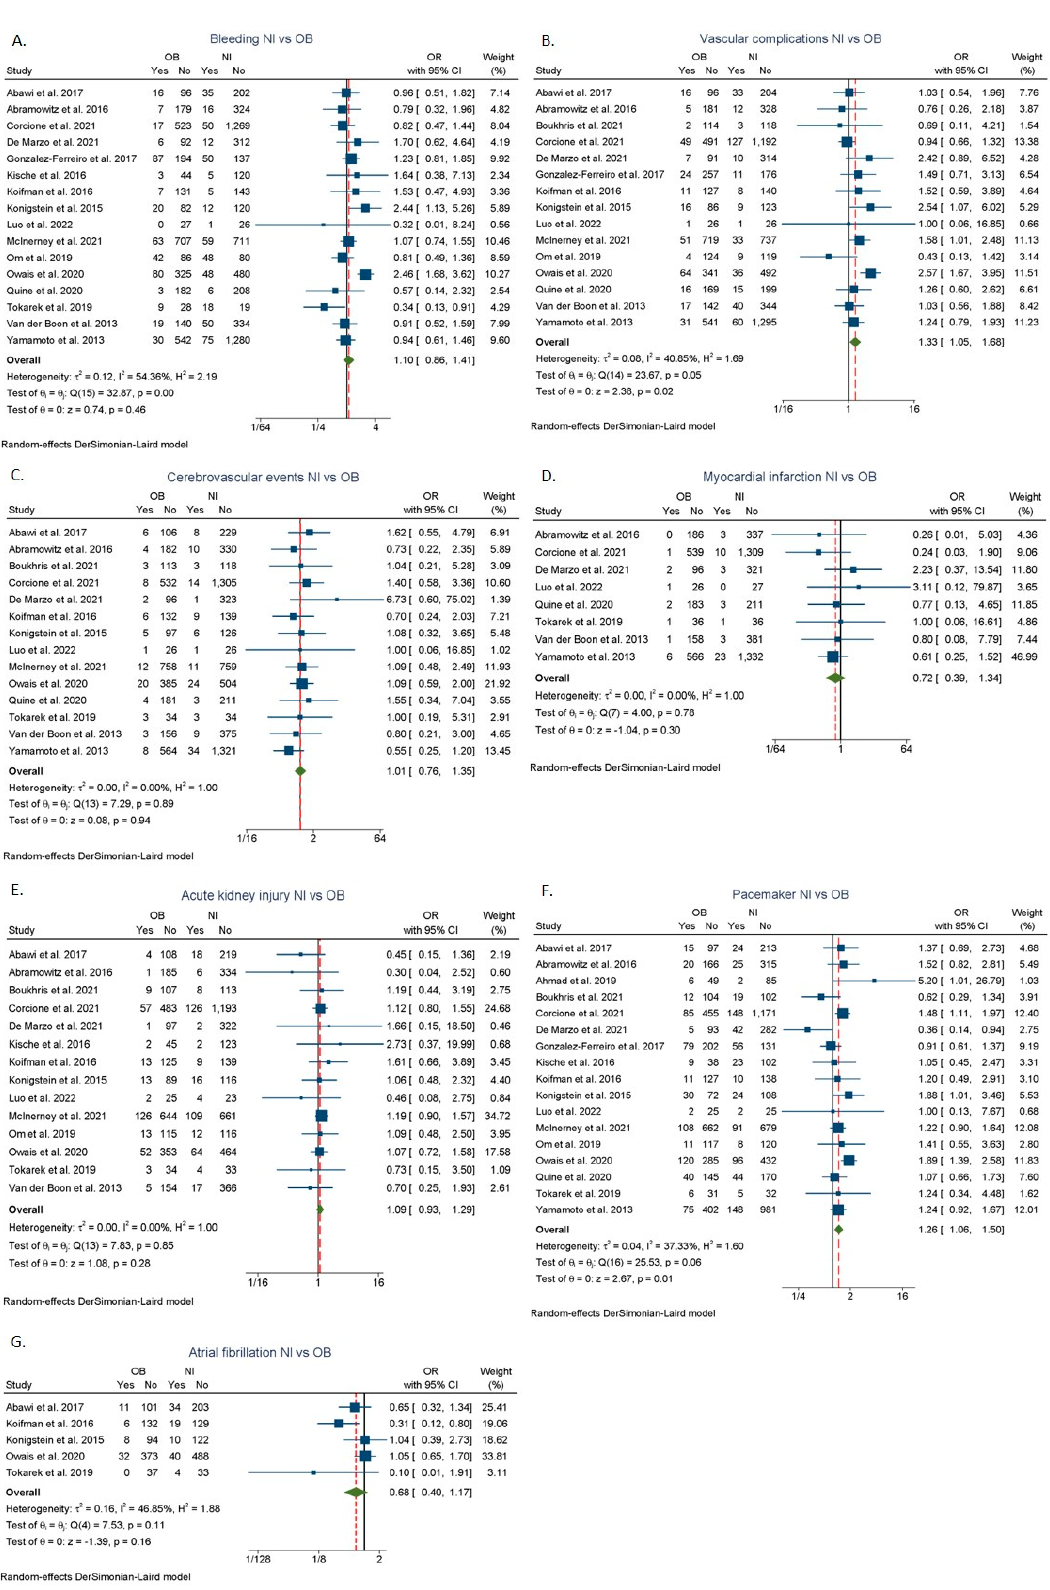
Figure 4. Complication rates after TAVR between normal BMI and overweight categories. ( A ) Ma- jor bleeding. ( B ) Major vascular complications. ( C ) Cerebrovascular events. ( D ) Myocardial infarc- tion. ( E ) Acute kidney injury. ( F ) Permanent pacemaker insertion. ( G ) Atrial fibrillation. Nl: nor- mal BMI; OW: overweight; OB: obesity; OR: odds ratio [7,9,12,22–26,29,31,32,34–37,42,43].